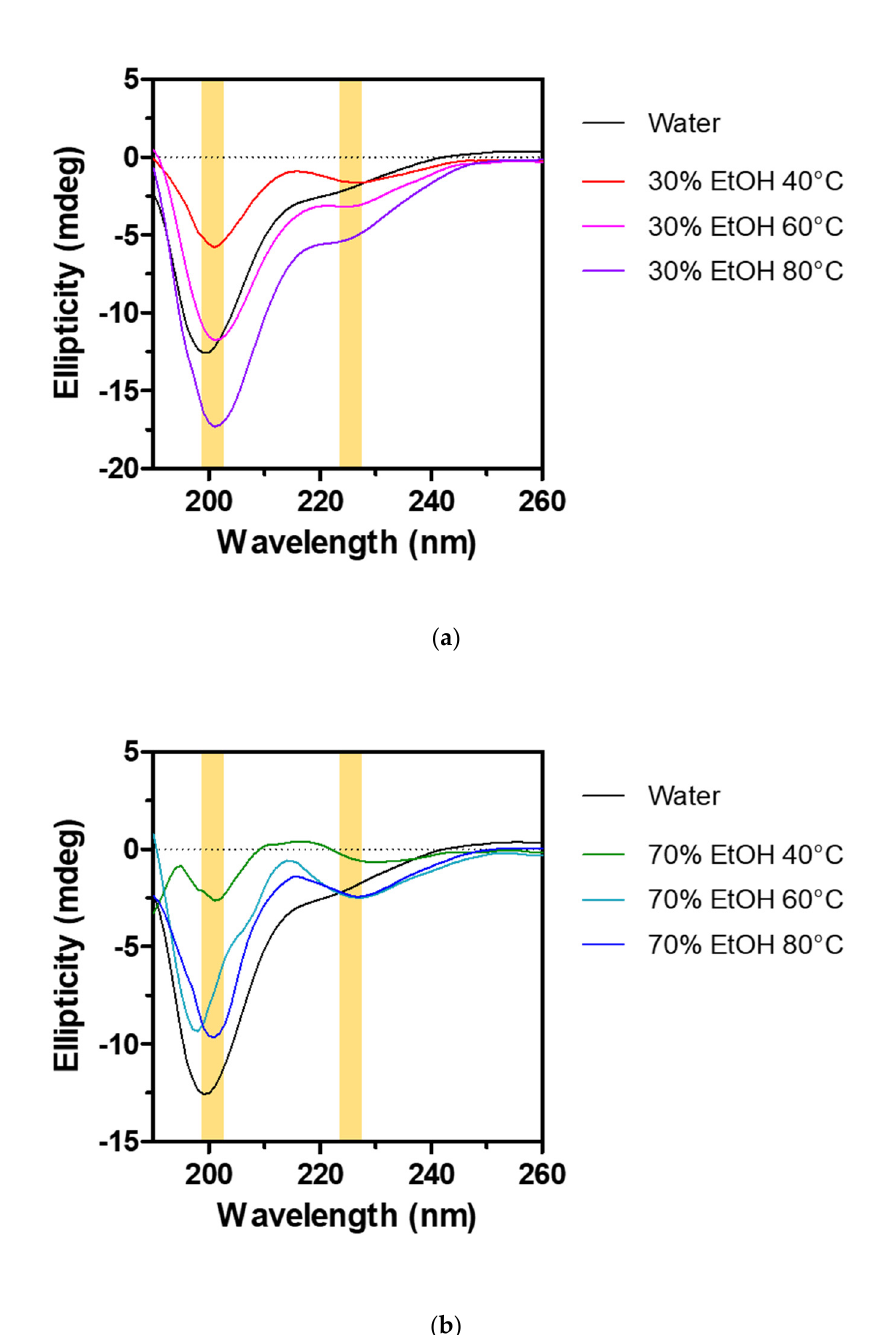
Figure 5. Effects of extraction conditions on the conformations of cocoon extracts in aqueous solution. CD spectra of various cocoon extracts prepared in 30% ethanol ( a ) and 70% ethanol ( b ) at 40 °C, 60 °C, and 80 °C. A cocoon extract prepared by the hot water extraction system was considered as a control. Yellow marks indicate the wavelengths corresponding to random coil and β -sheet conformations, respectively.